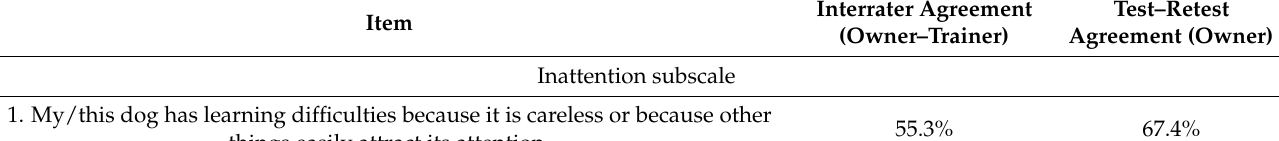
Table 5. Agreement between owner–trainer (interrater) ( n = 86) and within-owner (test–retest) ( n = 140) ratings (Aim 3/Question 2) at the item